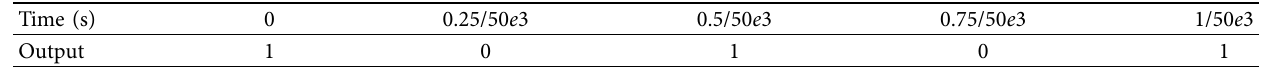
Figure 4: Switching signal generation for SMC rectifer stage. Table 3: Repeating sequence data to generate triangular carrier waveform for rectifer